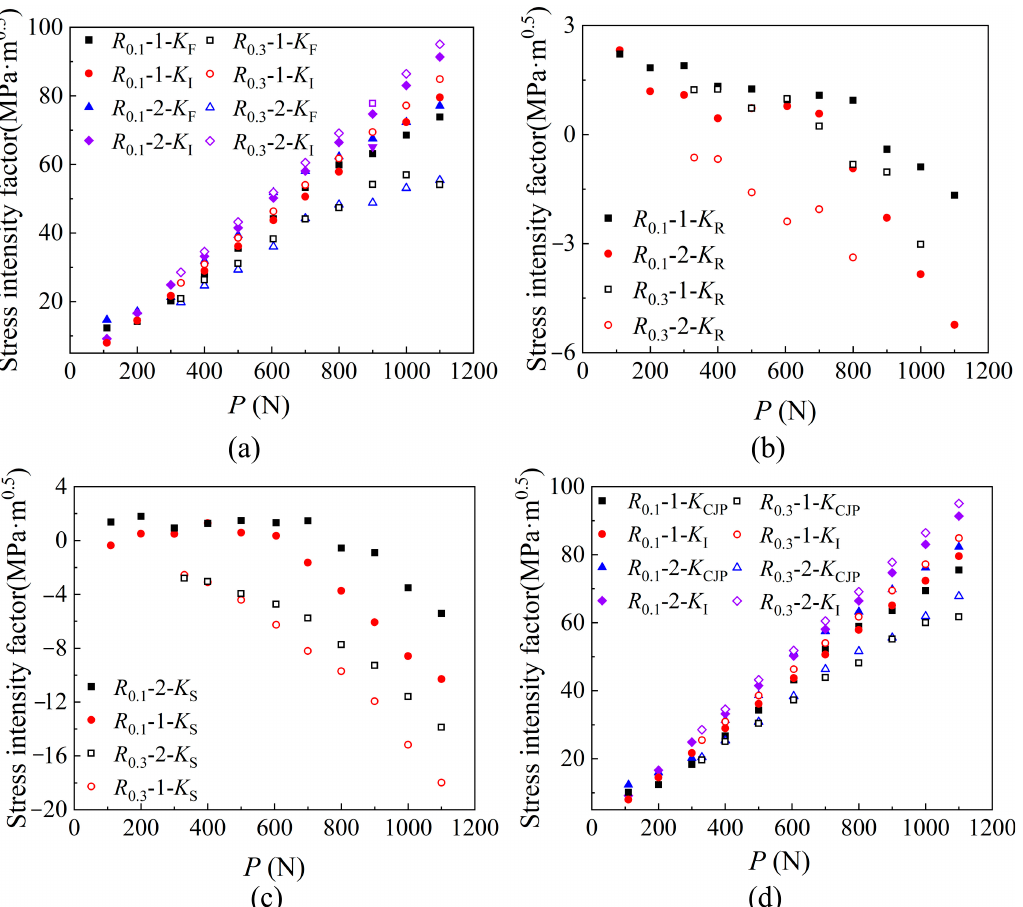
Figure 11. The variation of ( a ) SIF K R and ( b ) SIF K S with traditional SIF K I.